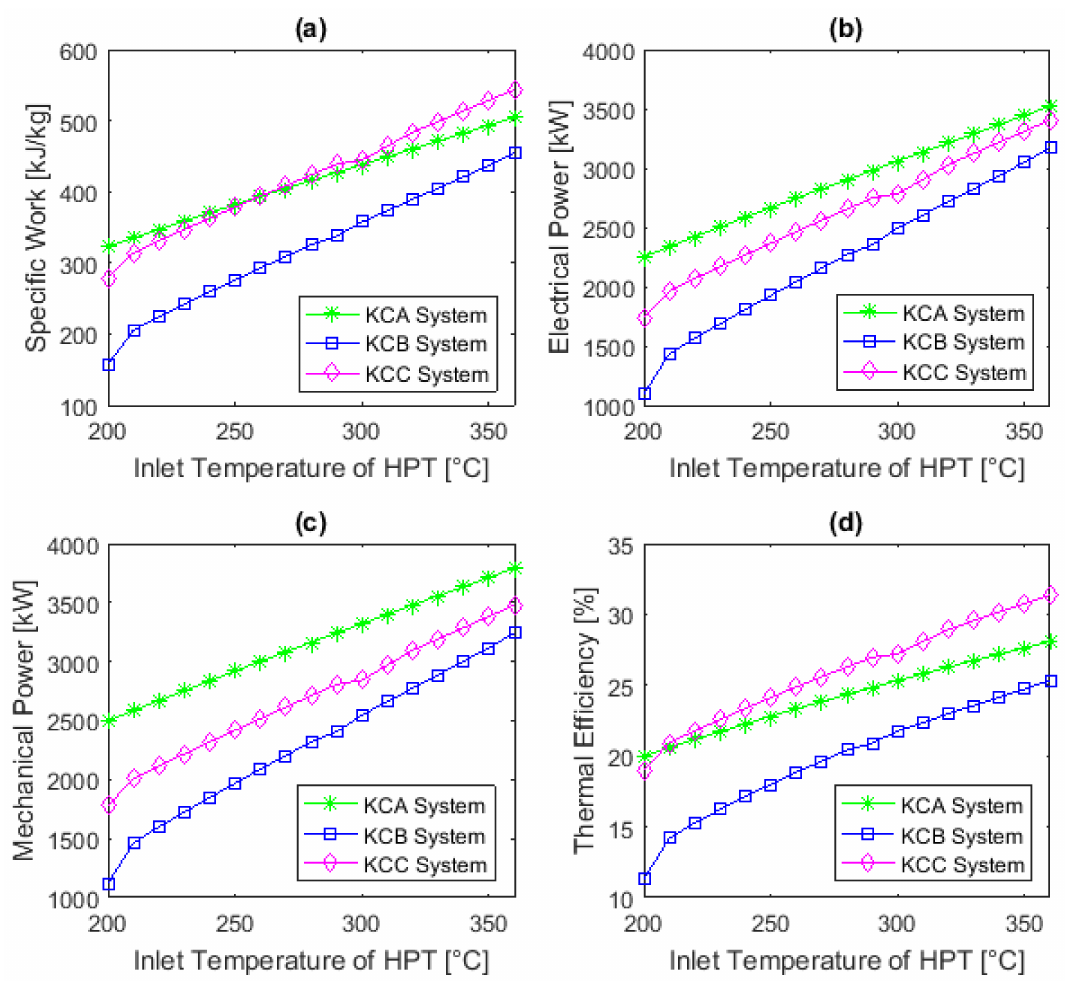
Figure 5. Effect of the inlet temperature of HPT on the: ( a ) specific performance, ( b ) electrical power, ( c ) mechanical power, and ( d ) thermal